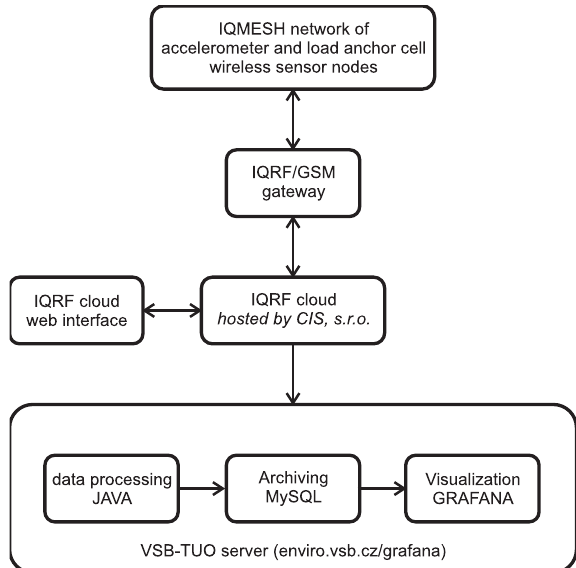
Figure 6. Scheme for processing, archiving, and visualizing measured data for case studies.